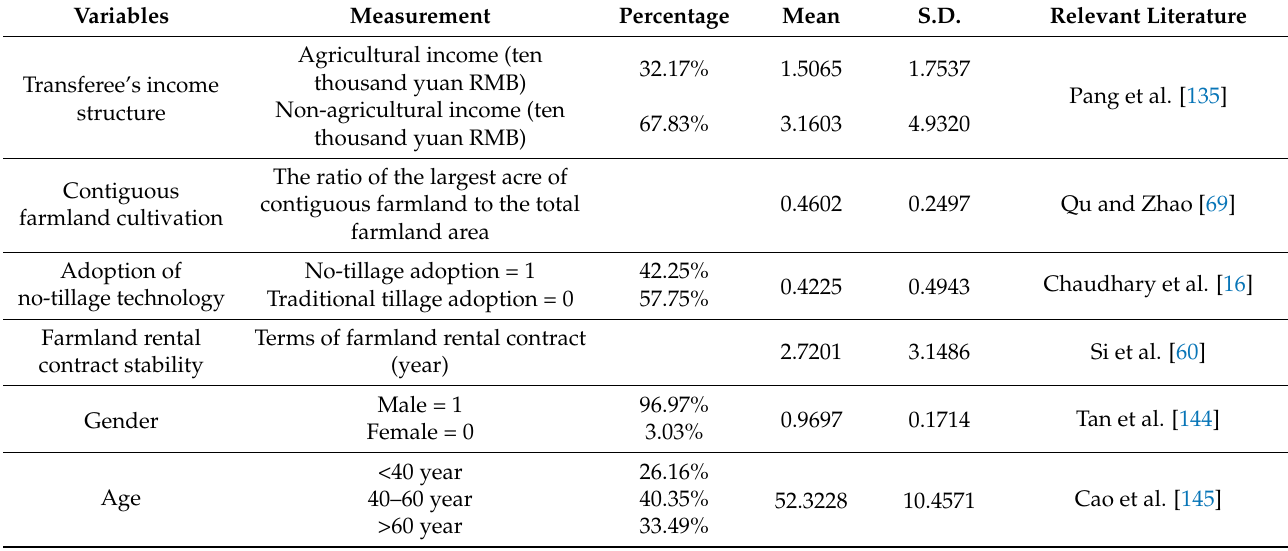
Table 1. Descriptive statistics of